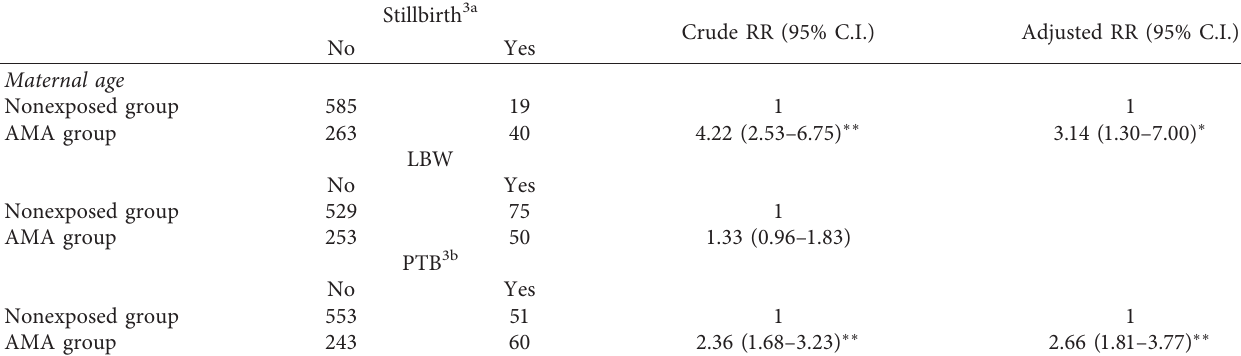
Table 3: Bivariate and multivariable analysis of maternal age and other variables associated with selected fetal adverse outcomes in Debre Markos referral hospital, Northwest Ethiopia, 2019 ( N E � 303 and N Ne �